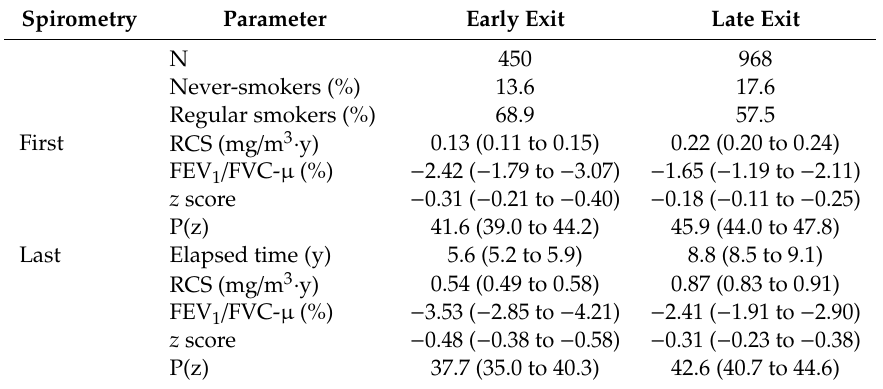
Table 4. Mean and 95%CI for FEV 1 / FVC and related parameters for early vs. late exit from mining